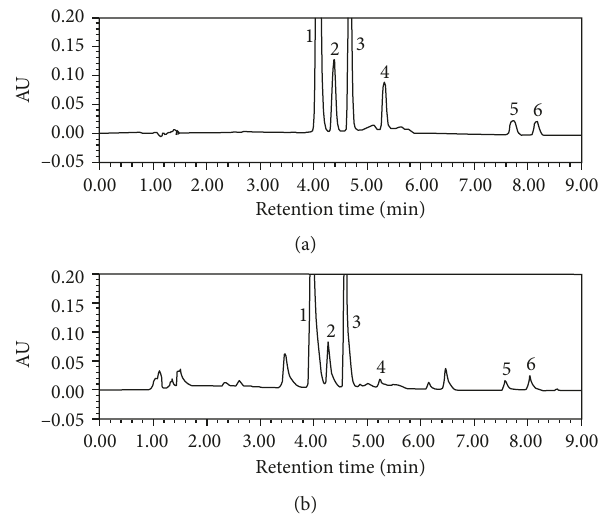
Figure 2: (a) Typical chromatogram of the standard mixture, containing 124.33 μ g/mL for naringin, 31.13 μ g/mL for hesperidin, 93.50 μ g/mL for neohesperidin, 1.653 μ g/mL for meranzin hydrate, 0.533 μ g/mL for naringenin, and 1.423 μ g/mL for hesperetin. (b) Typical chromatogram of FA decoction sample diluted for 400 times at 284nm, containing 63.75 μ g/mL for naringin, 12.48 μ g/mL for hesperidin, 35.70 μ g/mL for neohesperidin, 0.875 μ g/mL for meranzin hydrate, 0.675 μ g/mL for naringenin, and 0.475 μ g/mL